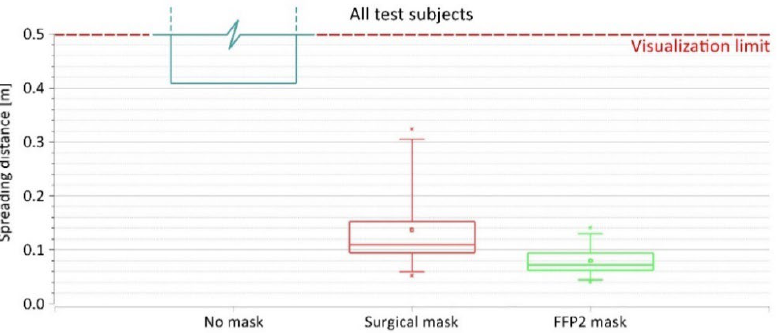
Figure 8. The spreading distance of exhaled air from all test subjects when wearing no mask, surgical mask, and FFP2 mask.